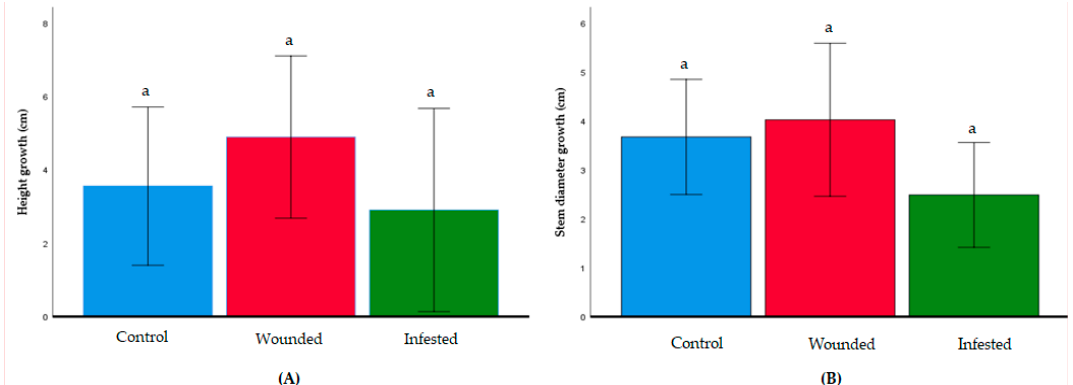
Figure 2. Growth of each E. guineensis group. ( A ) Growth in terms of increase in palm height; ( B ) growth in terms of increase in stem circumference. Data shown as mean + S.D. No significant differences among the control, wounded, and infested group were observed based on analysis of variance (ANOVA) following the Tukey multiple comparison test ( p > 0.05).